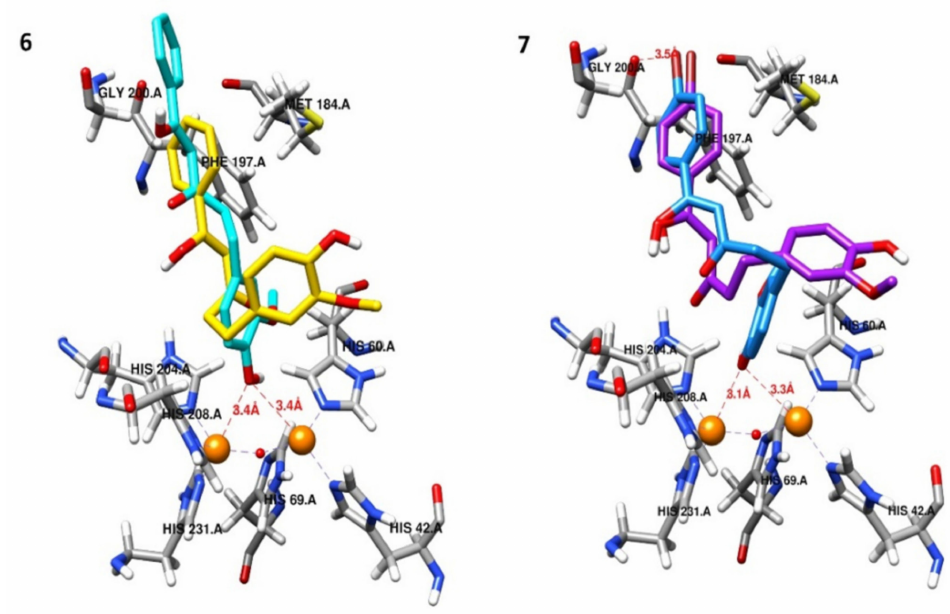
Figure 11. Representation of the two best docking poses of compound 6 and 7 facing the catalytic site where histidines and copper ions are represented at the bottom with sticks and balls, respectively. On the left : lowest energy (cyan) and the most populated pose (yellow) of compound 6 . On the right : lowest energy (light blue) and the most populated pose (purple) of compound 7 .